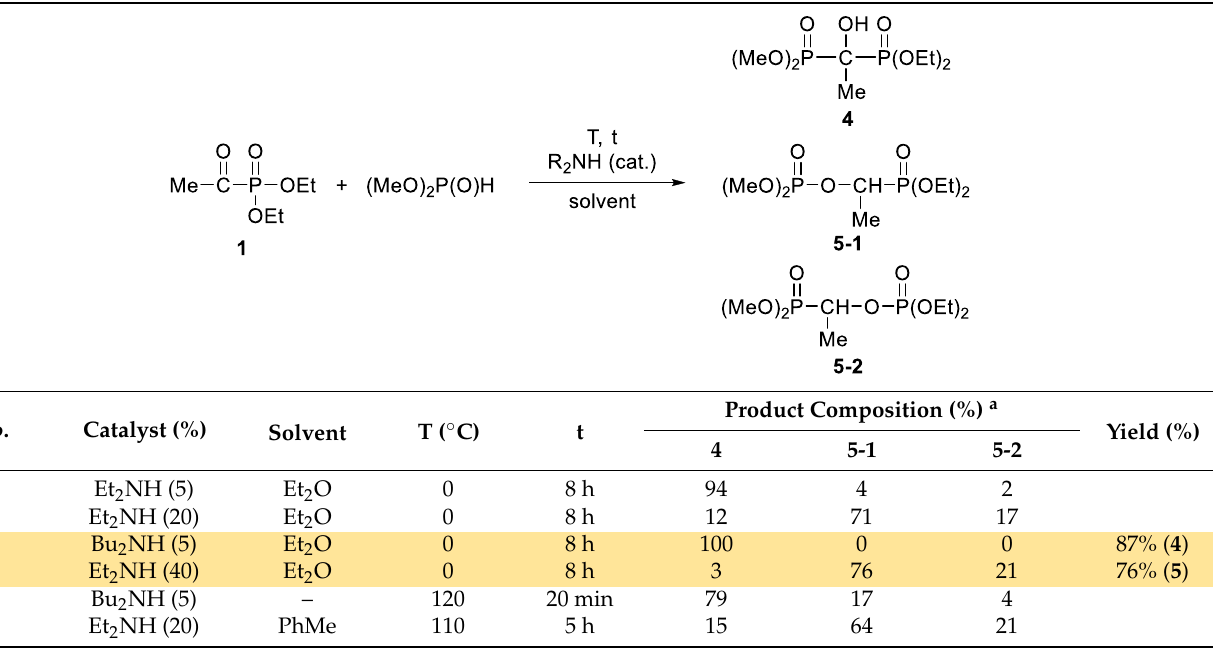
Table 2. The reaction of diethyl α -oxoethylphosphonate ( 1) , with dimethyl phosphite under different conditions. Exp.